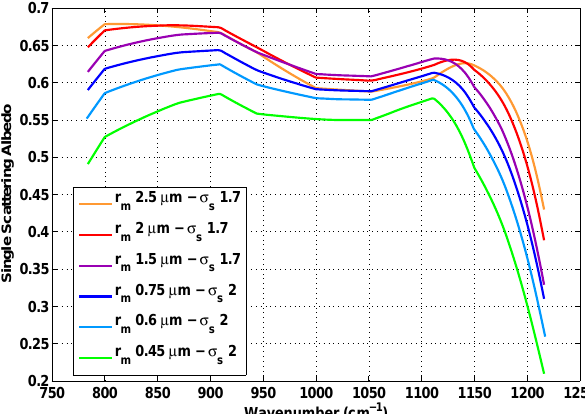
Fig. 1. Single scattering albedo computed using a Mie code, for different log-normal particle number size distributions and the dust refractive index from the GEISA-HITRAN